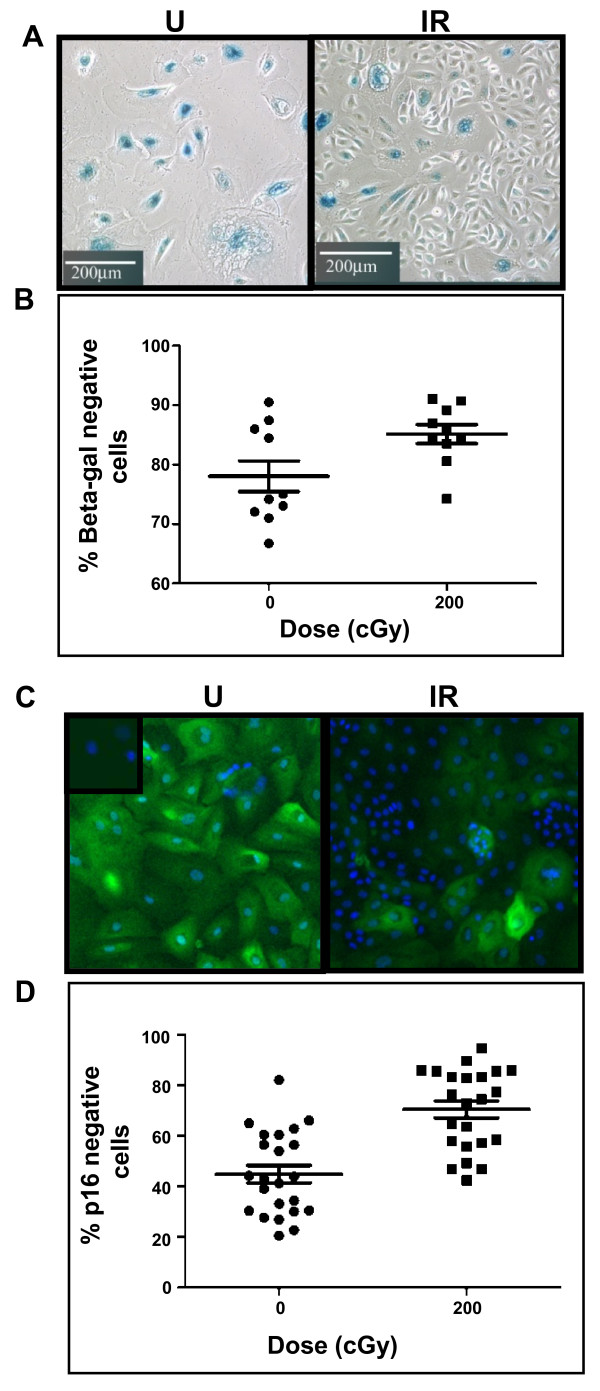
Cultures derived from irradiated human mammary epithelial cells show more SA-βgal (-) and p16 (-) cells than those derived from unirradiated human mammary epithelial cells. Representative fields are shown stained for (A) SA-βgal activity (blue reaction product) or (C) total p16 protein (green immunofluorescence). In (C), cell nuclei were counterstained with DAPI (blue). Inset = minus 1°Ab control. Note the greater presence of SA-βgal (-) and p16 (-) cells in the irradiated cultures. In (B) and (D), cytometry was used to quantitatively compare the percentages of positively and negatively staining cells in the corresponding cultures. In (B), flow cytometry results of an experiment performed using B1450 cultures are summarized in a mean ± SE scatter plot (P < 0.001, non-parametric Wilcoxon test). In (D), the percentages of p16 (-) cells in unirradiated and irradiated B1400 and B1450 cultures were determined using a Cellomics Array Scan VTI automated fluorescence microscopic imaging system. For each condition, staining was measured for 460 fields per well and summarized in a mean ± SE scatter plot (P < 0.0001, non-parametric Wilcoxon test).